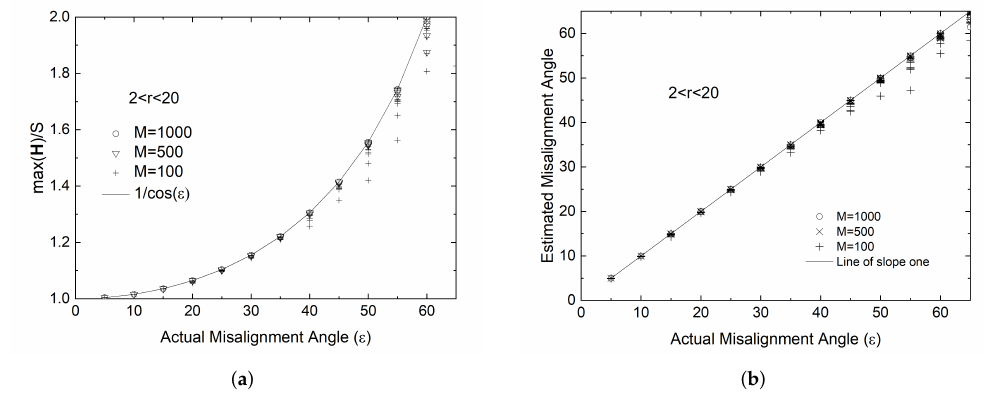
Figure 5. ( a ) Results of MC simulations, illustrating a correlation between max ( H ) and (cid:101) (in degrees), obtained for 2 < r < 20, and for various sample sizes M. The correlation is valid for any r ≥ 2 and 0 < (cid:101) < 60 ◦ and for sample size M ≥ 10 3 . ( b ) Parity graph between the actual misalignment angle (cid:101) and the value of (cid:101) est computed from Equation